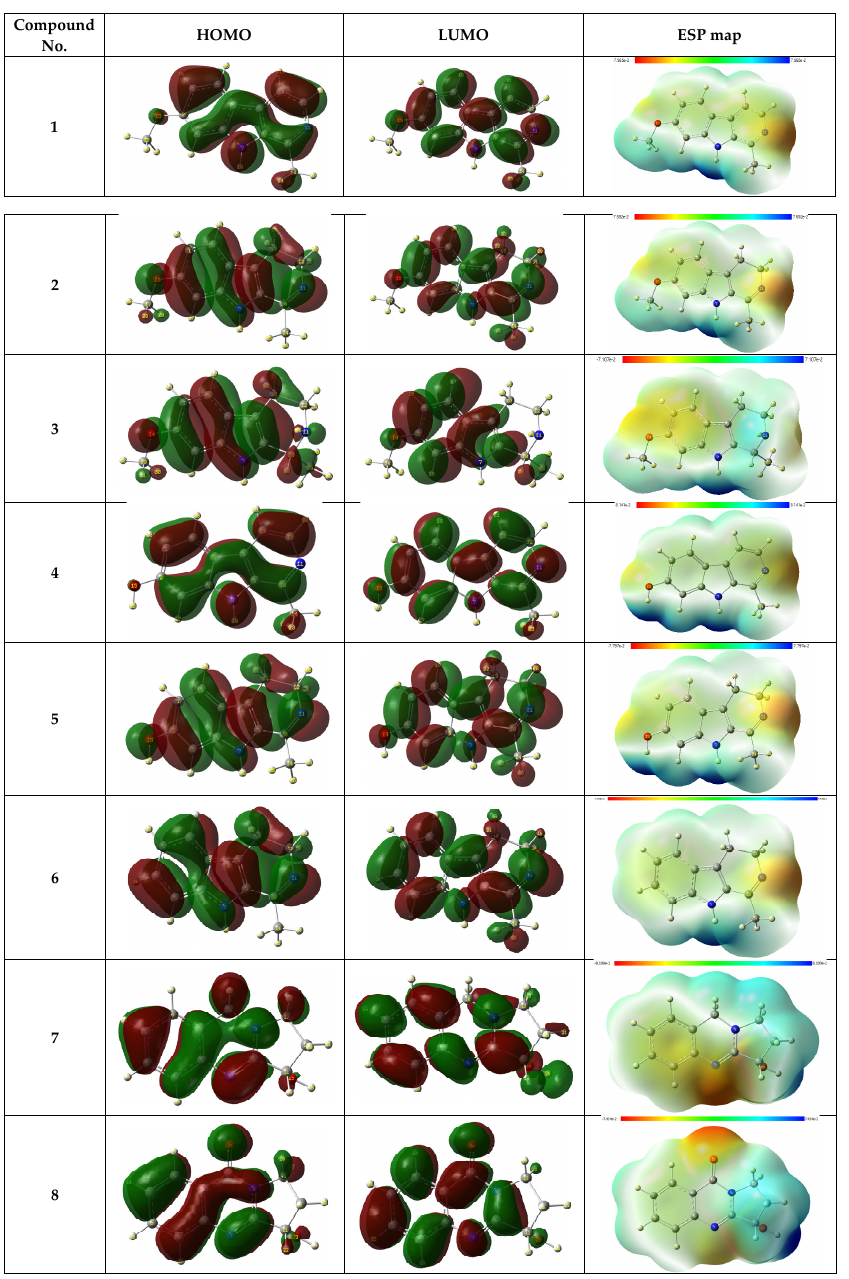
Figure 15. Frontier molecular orbitals (HOMO and LUMO) and electrostatic potential (ESP) maps of the stable conformers for the neutral form of compounds 1 – 8 by B3LYP method with 6-311G++(d,p) basis set using water as the solvent [49].